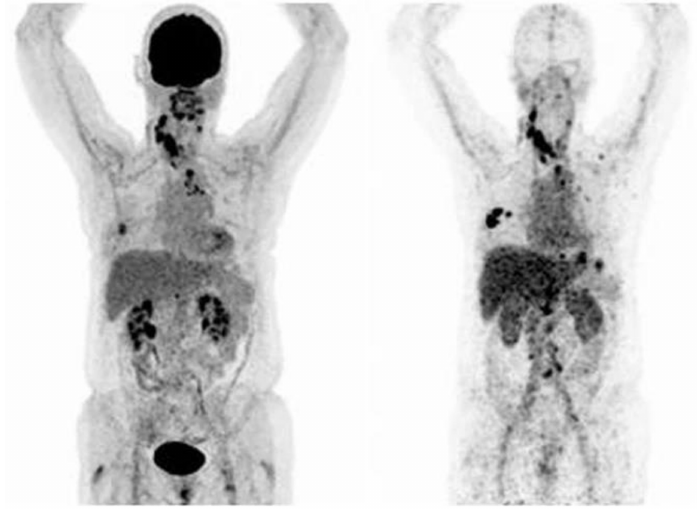
Figure 2. PET-Scan of [18F]FDG (left) and [ 89 Zr]Zr-trastuzumab (right) of a patient with a [ 89 Zr]Zr- trastuzumab scan considered HER2-positive (Figure adapted from Bensch et al. [53] Creative Com- mons Attribution 4.0 International